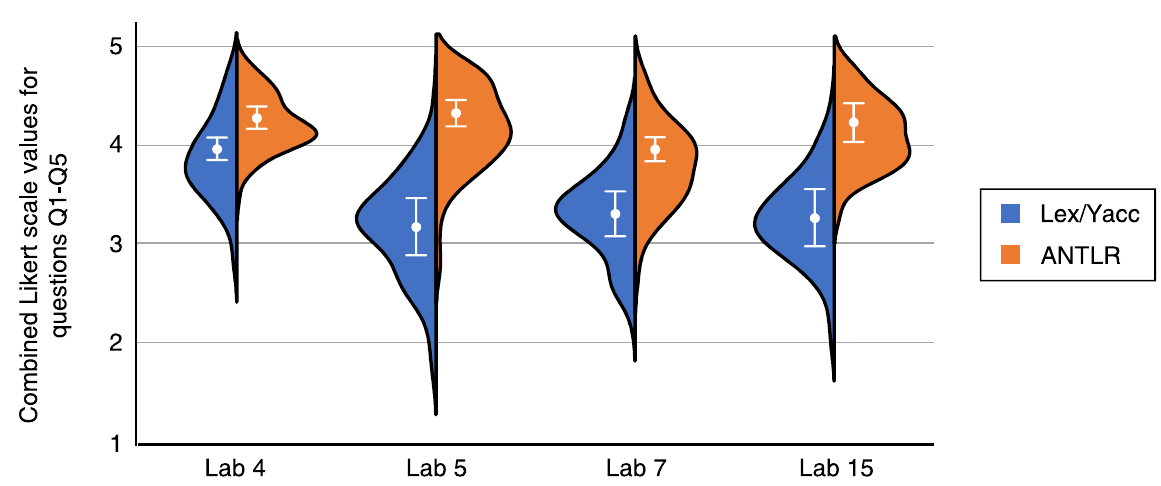
Fig 2. Combined Likert scales for the questions Q1-Q5 of the questionnaire in Table 5. Whiskers represent 95% confidence intervals and the points denote their mean values.